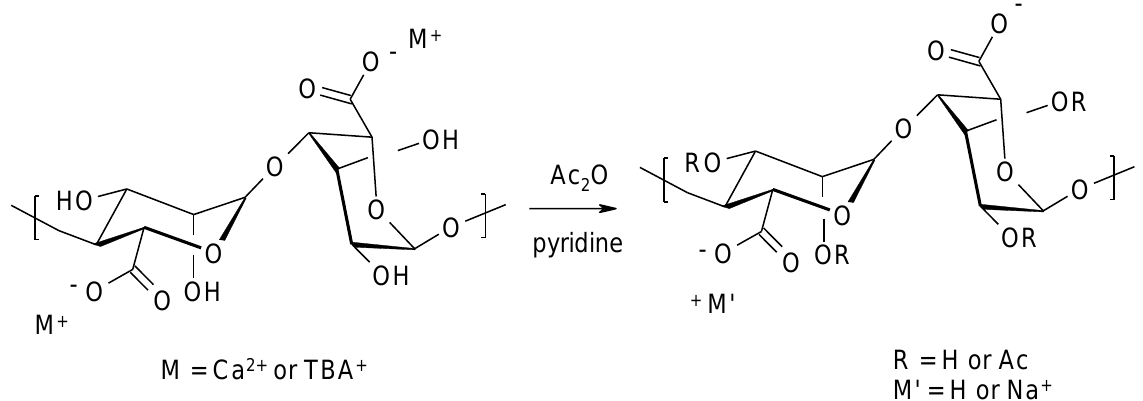
Figure 6. Acetylation of alginate using a mixture of pyridine/acetic anhydride. Gel acetylation: M = Ca 2+ or TBA + . Acetyla- tion of a homogeneous system in DMSO/TBAF, M = TBA + , M’= -H + or Na + .